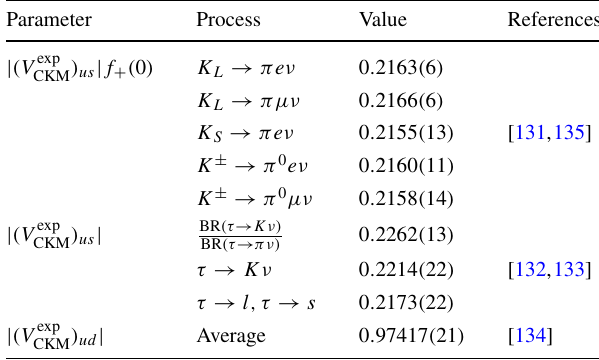
Table 3 Experimental measurements for all tests of lepton universality Obs.